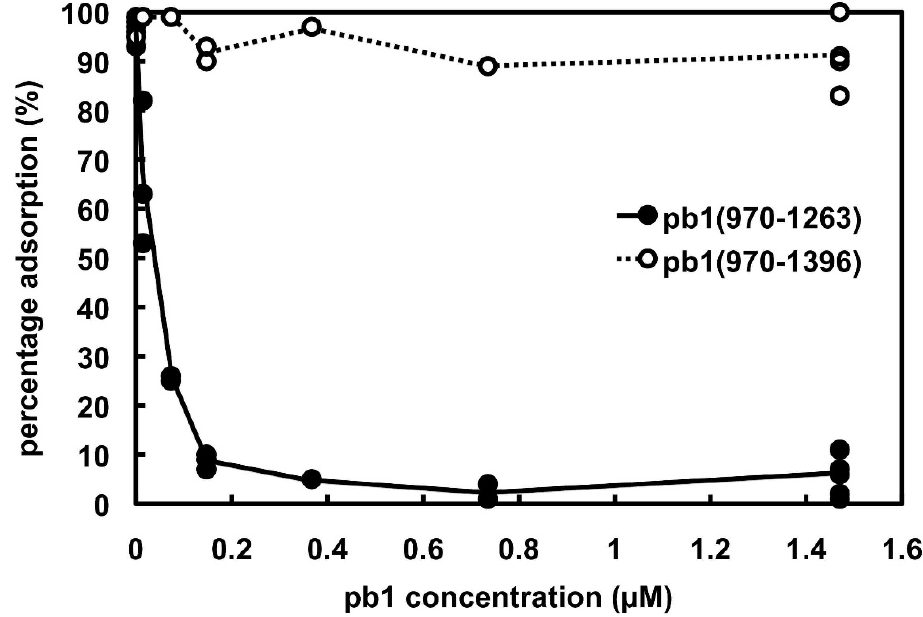
Figure 1. Inhibition of L-shaped tail-fibre dependent bacteriophage T5oad mutant by purified pb1 proteins. Escherichia coli F (5 × 10 7 cells in 0.05 mL) were incubated with pb1(970–1263), the carboxy-terminal domain of the mature protein and pb1(970–1396), the carboxy-terminal domain of the uncleaved mutant protein at the concentrations shown and un-adsorbed phages were titrated by plaque counting. Concentrations are of the trimeric proteins.